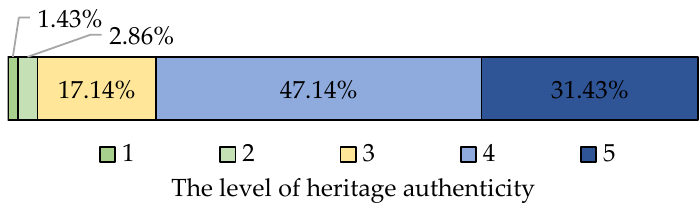
Figure 3. The assessment of ERIH sites’ heritage authenticity.